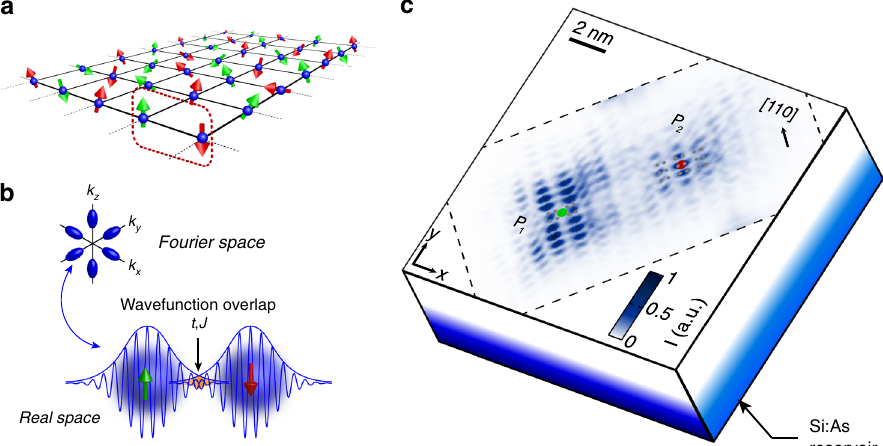
Fig. 1 Direct measurement of coupled donors in silicon. a Schematics of a 2D-array of single electron spins bound to phosphorus atoms in 28 Si, where two-qubit operations can occur between nearest neighbours, i.e. red/green spin pairs, using the Heisenberg exchange interaction. b (Top) A donor ’ s electron wavefunction oscillates at the valley wavevector k μ ~ 0.81k 0 , with k 0 = 2 π / a 0 . Silicon presents a mass anisotropy which results in the donor orbital envelope to be anisotropic as well, as highlighted by their ovoidal shape in Fourier space. (Bottom) Tunnel and exchange interactions result from the overlap between the two donor orbitals, represented by the yellow overlap area, which is sensitive to both envelope decay and valley interference between donors. c Experimental real-space map of the quasi-particle wave function of an exchange-coupled donor pair ’ s two-electron neutral state. Sequential transport occurs vertically from a highly doped Si:As substrate, which acts as an electron reservoir, to a donor pair found in a low-doped phosphorus δ - layer, and then to the STM tip above (not shown). The red and green dots represent the surface projections of the pinpointed lattice positions of the two ffiffiffi p donors. The two donors are separated by 6 : 5 a 2 along [110] (perpendicular to the Si dimers, a 0 is the silicon lattice constant), 0 : 5 a 0 Si dimers) along ½ 1 (cid:1) 10 (cid:2) , and by 1.25 a 0 in depth. The grey dots represent the silicon atom positions of the 2 × 1 reconstructed surface. The black dashed contour indicates the experimentally measured